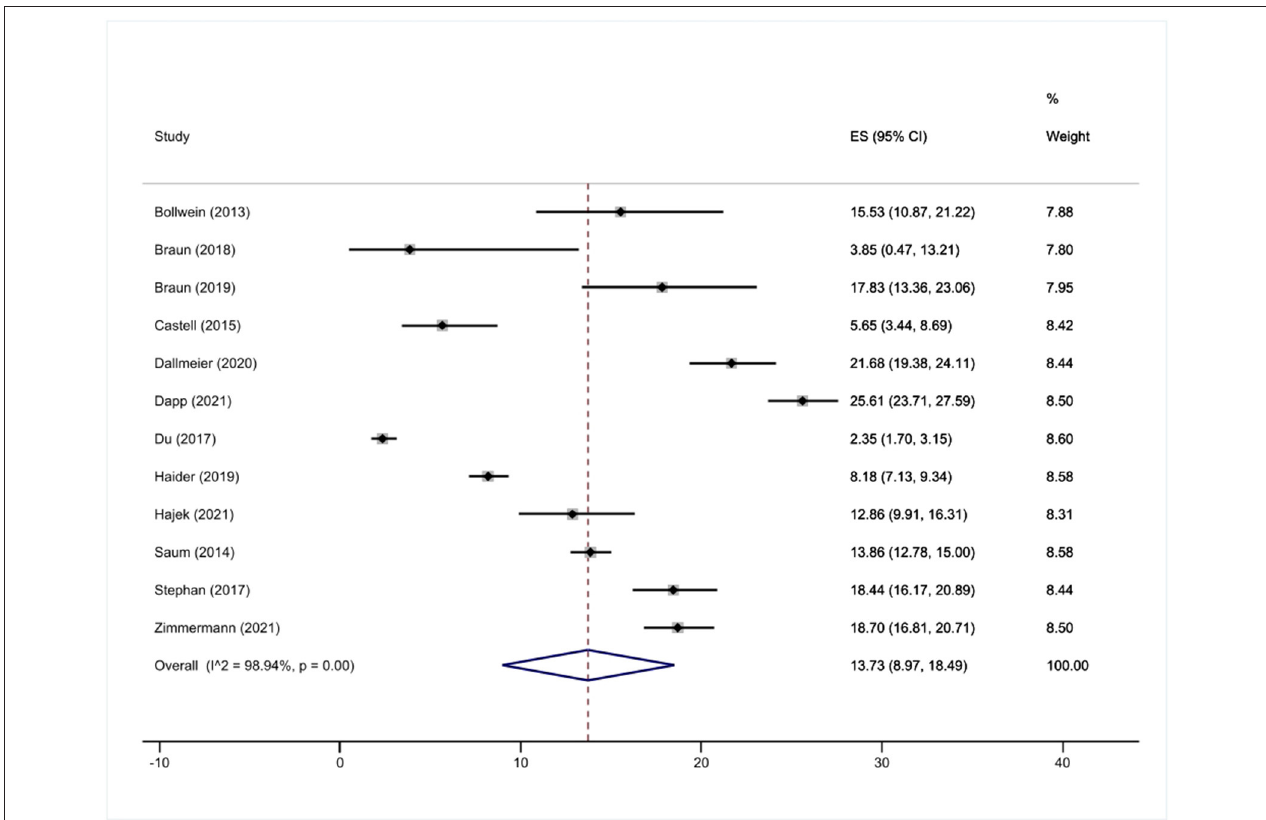
FIGURE 2 | Meta-analysis